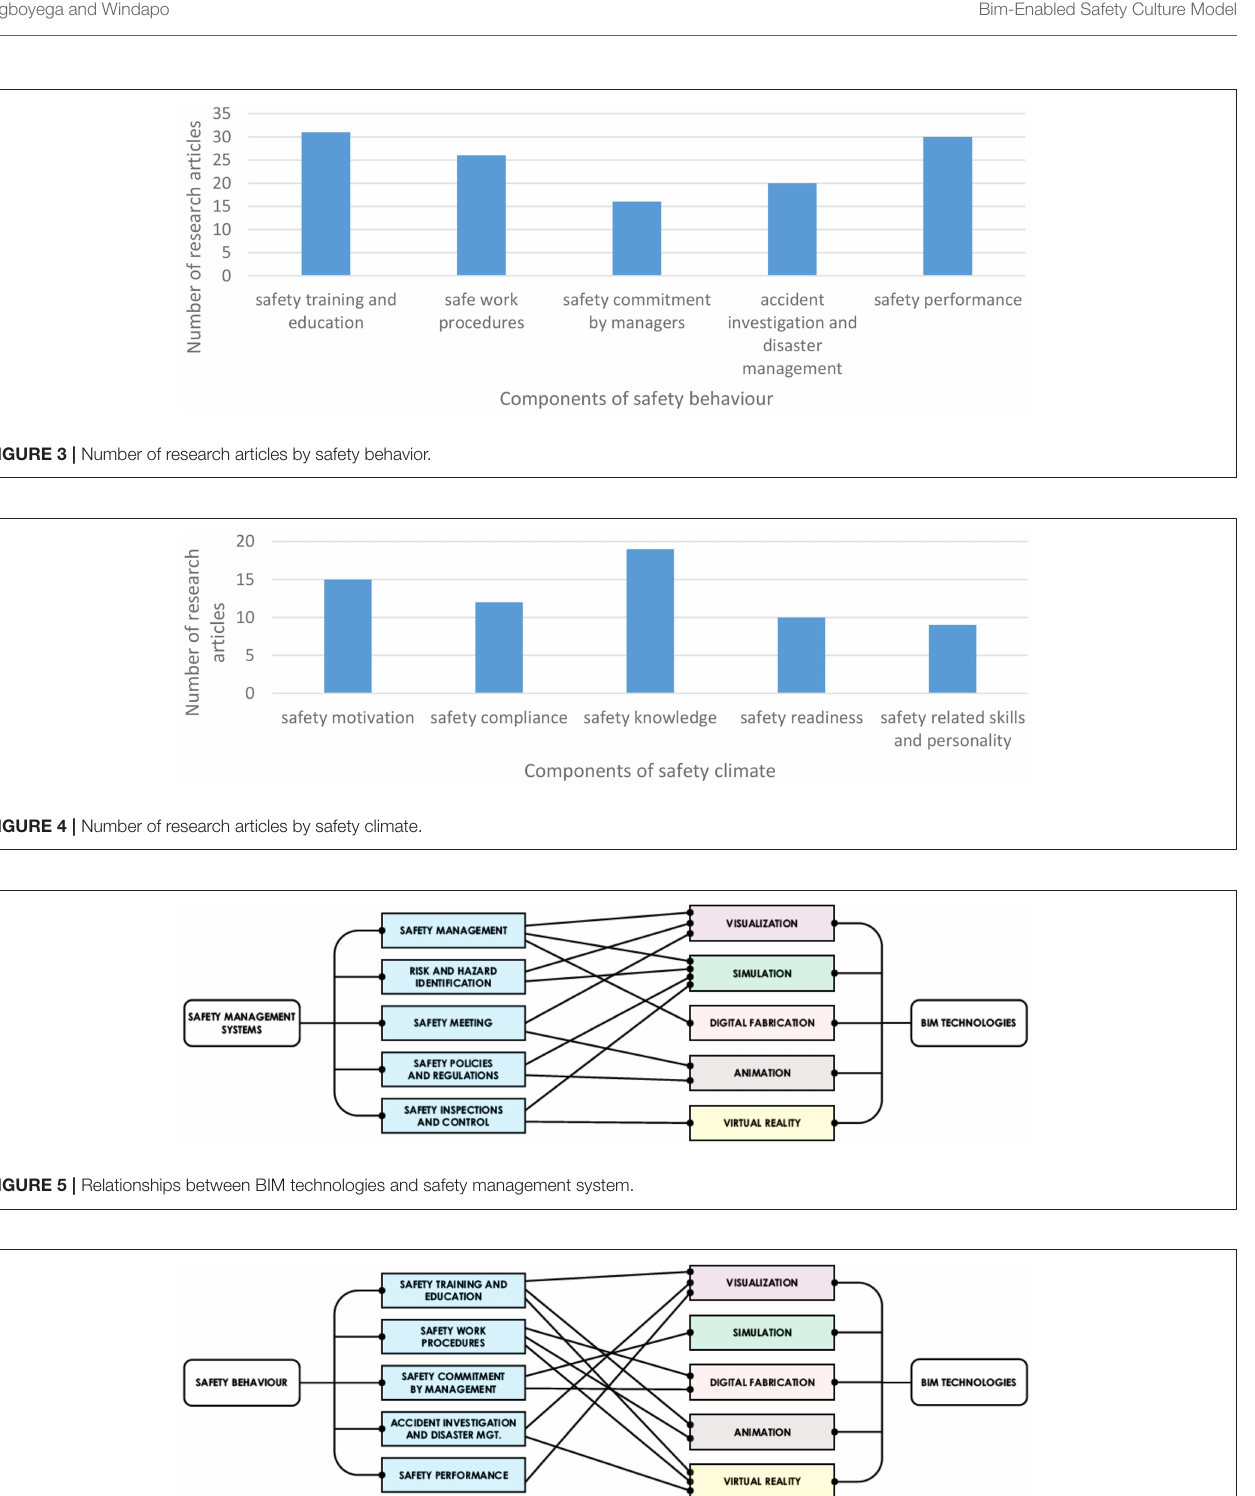
Frontiers in Built Environment |